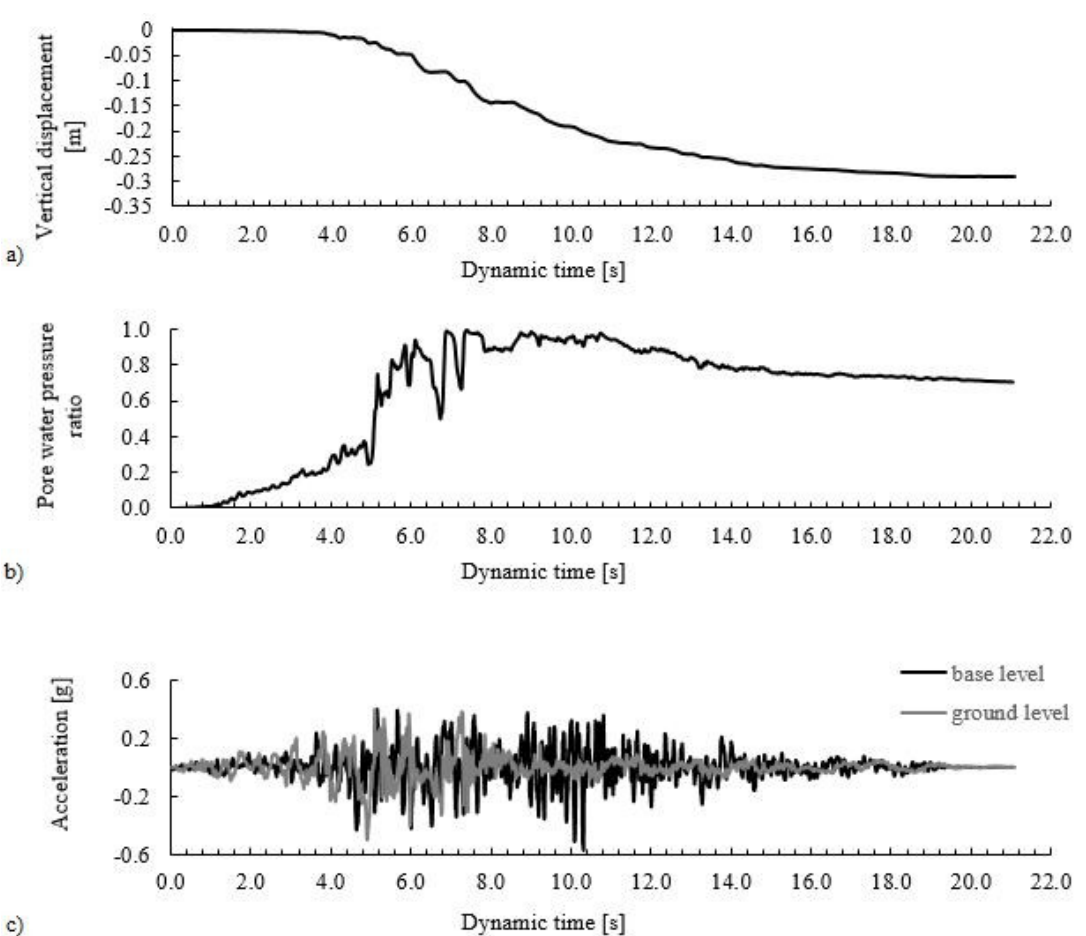
Figure 6. Vertical crest displacement ( a ), pore pressure ratio ( b ) and acceleration time ( c ) histories.